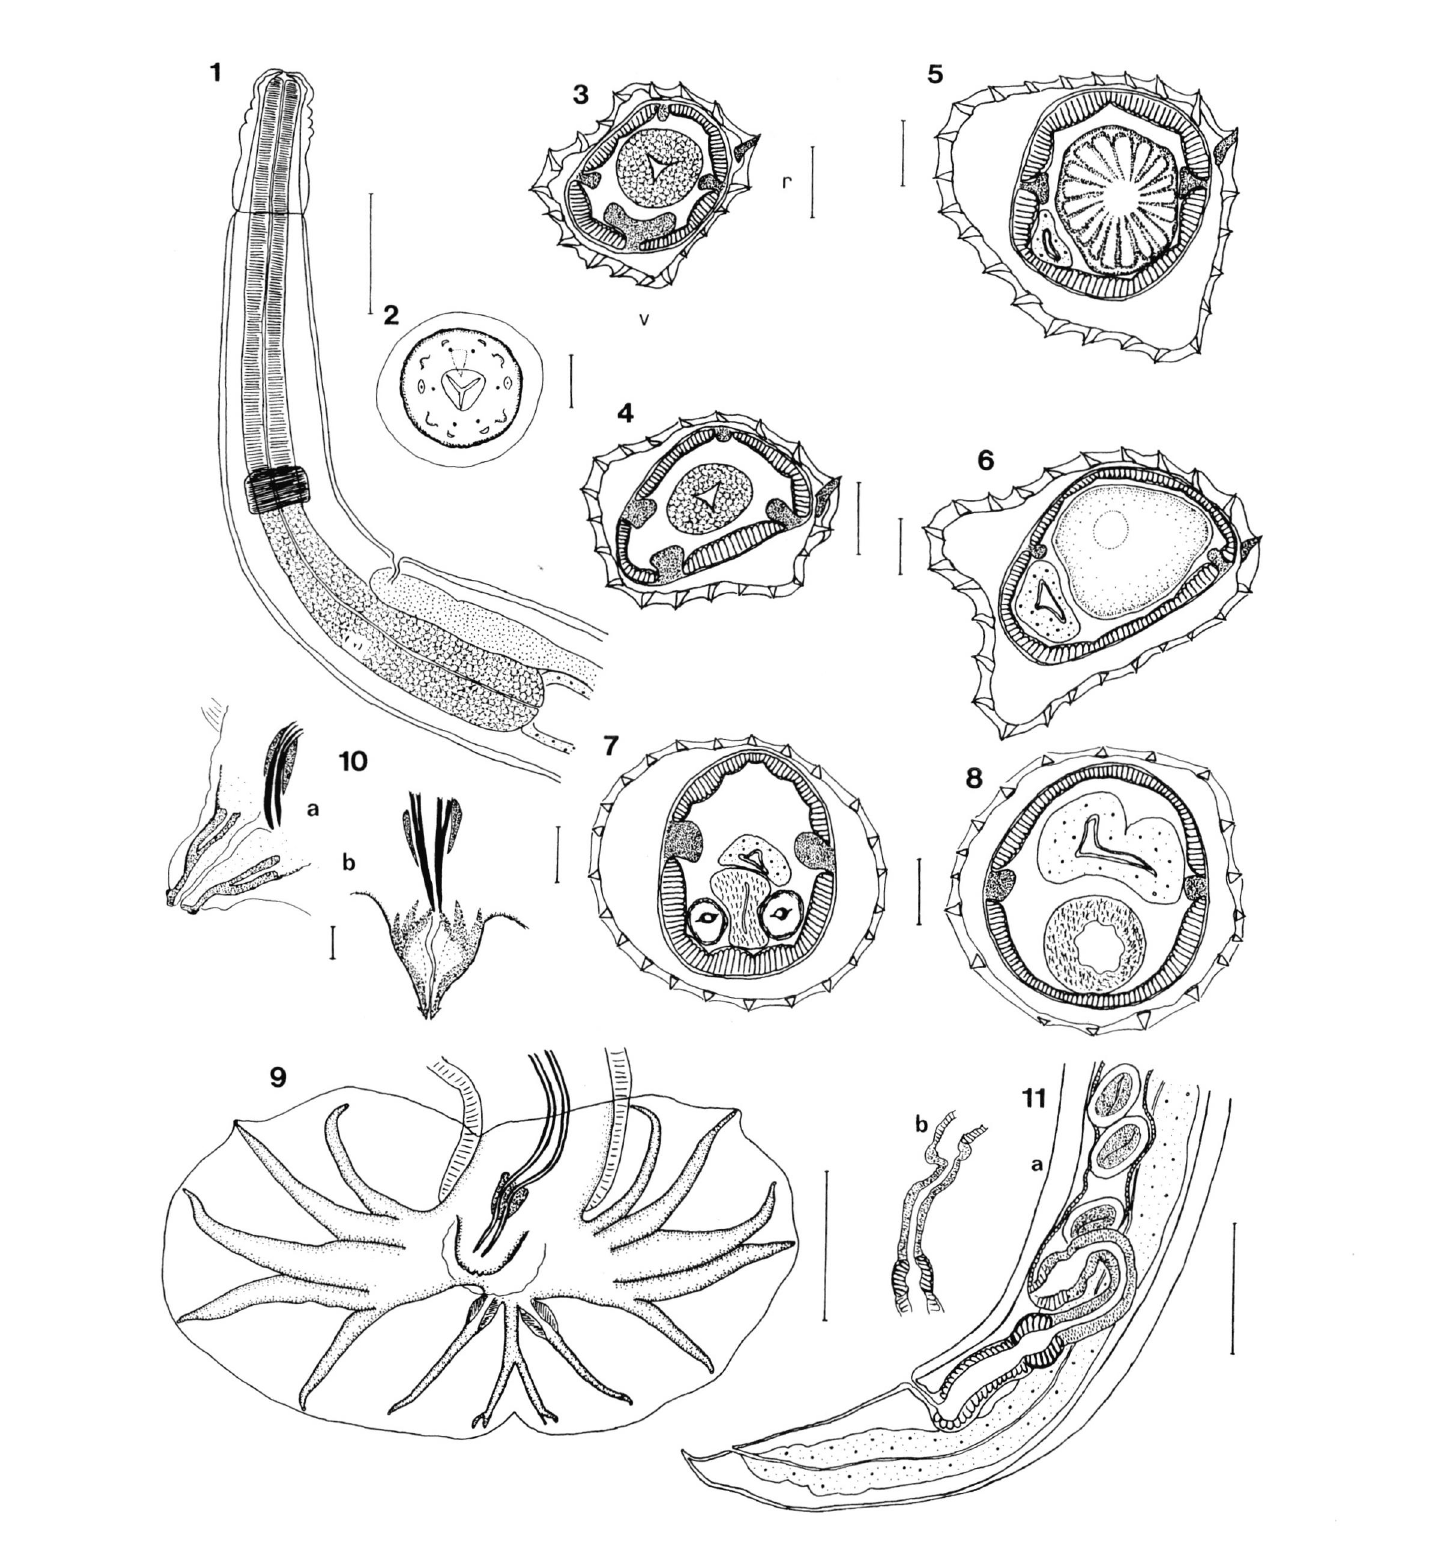
Figs 1-11. - Hassalstrongylus puntanus n. sp. from Graomys griseoflavus. 1, male, anterior extremity, right lateral view. 2, female, head, apical view. 3-8, transverse sections of body (largest ridge shaded); 3-4 at oesophago-intestinal junction, 3, male, 4, female; 5-6, at mid-body. 5. male, 6, female; 7-8, at posterior end, 7, male, 200 µm anterior to caudal bursa. 8. female, just anterior to vulva. 9, male, caudal bursa, ventral view. 10a, male, genital cone, left lateral view, 10b, male, genital cone, ventral view. 11a, gravid female, posterior extremity, left lateral view, 11b, non-gravid female, posterior extremity, schema of proximal part of infundibulum and distal part of uterus, transversally enlarged. Abbreviations: r. right, v. ventral. Scale bars: 1. 50 µm; 2. 10. 10 µm: 3. 4, 7, 8, 20 µm; 5, 6, 25 µm; 9. 11a. 100 µm.